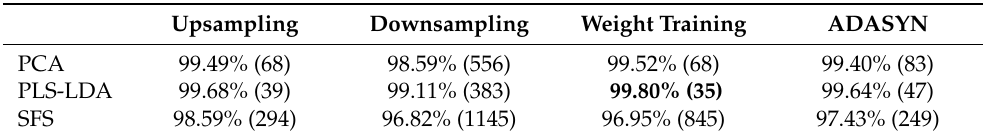
Table 6. Balanced accuracy score and the number of misclassified samples (values in parentheses) for